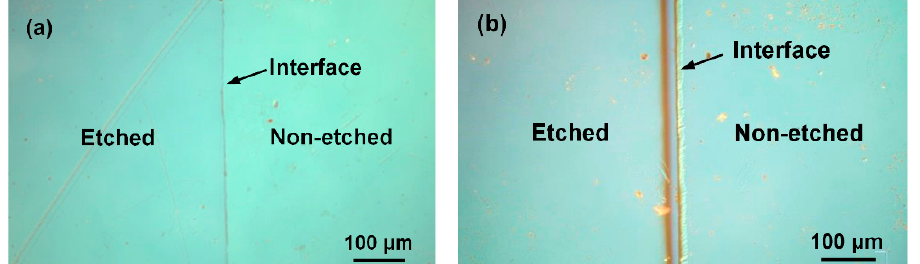
Figure 8. Optical micrographs of the ( a ) YF 3 and ( b ) Al 2 O 3 substrates after exposure to fluorocarbon plasma.